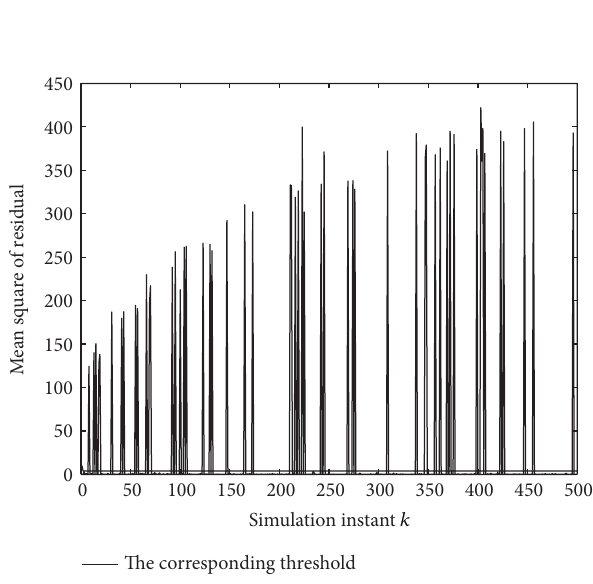
Figure 2: Mean square of